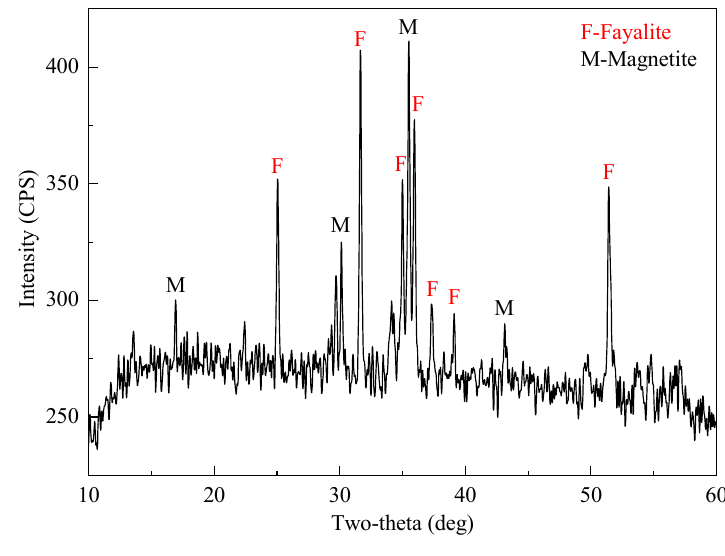
Figure 1. XRD spectrum of the sample. Table 2. Mineral composition of the sample.